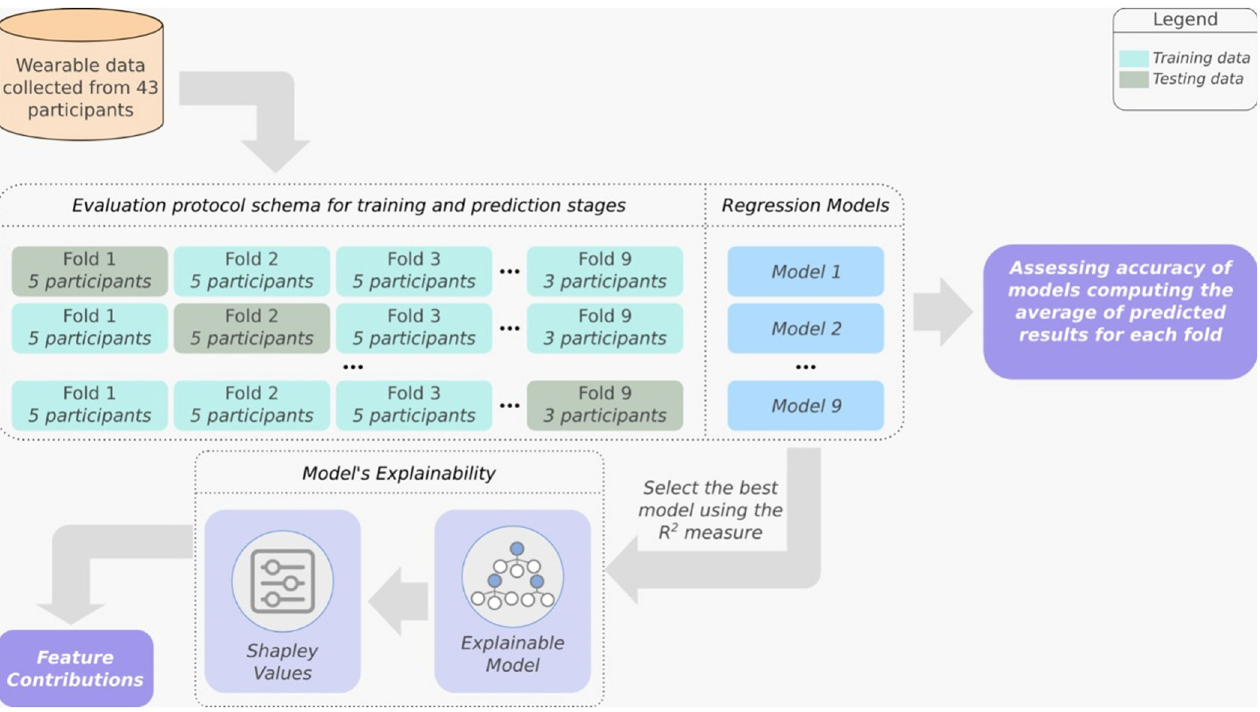
Fig 2. Evaluation protocol adopted for this study. Given a dataset containing wearable data from 43 participants, we first use the k-fold cross-validation (k = 9) to evaluate generalization aspects of regression models. Then, we use the R-squared measure to select the best model, which is used to build an explainable model via Shapley values to assess the feature contributions. We also computed the average Mean Absolute Error (MAE), and Pearson correlation to assess the accuracy of regression models.